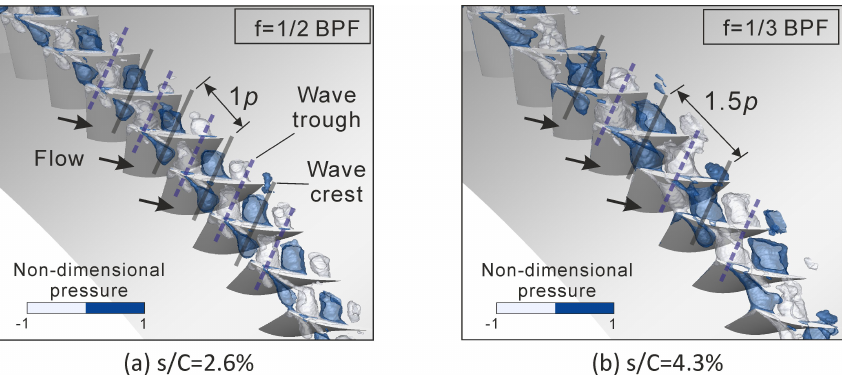
Figure 11. Visualization of top-ranked DMD modes ( s / C = 2.6% at Φ = 0.50; s / C = 4.3% at Φ = 0.51).